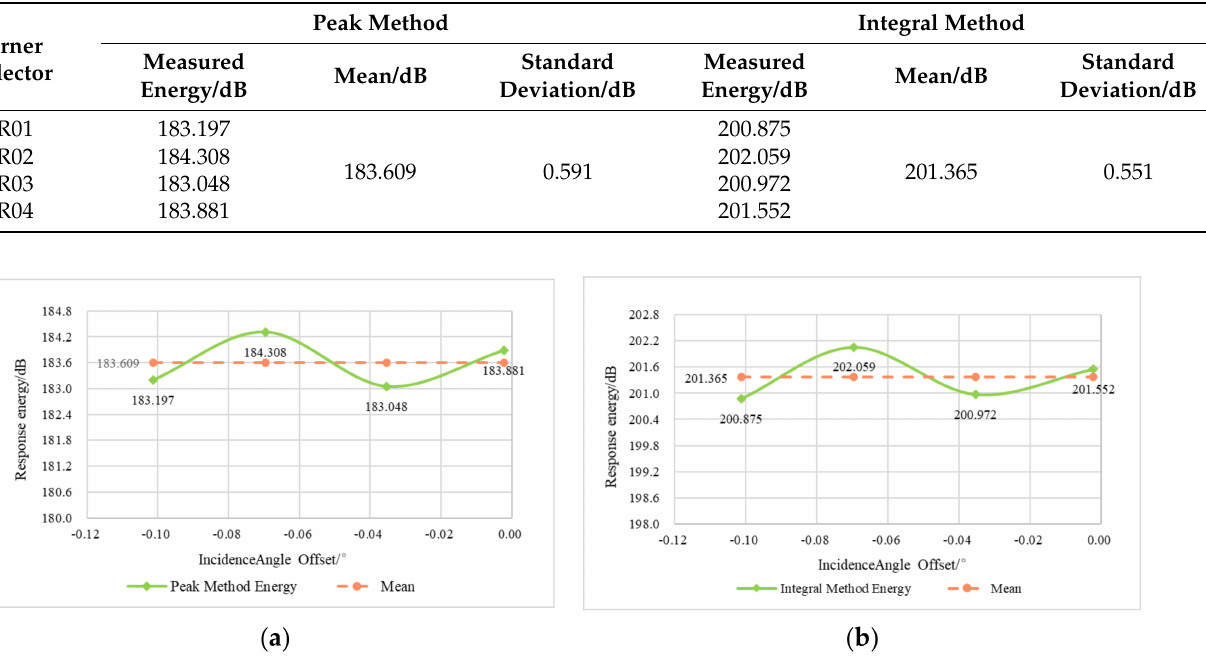
Figure 8. Verification of the correction results for the corner reflector antenna pattern in the VV polarimetric image: ( a ) peak method; ( b ) integral